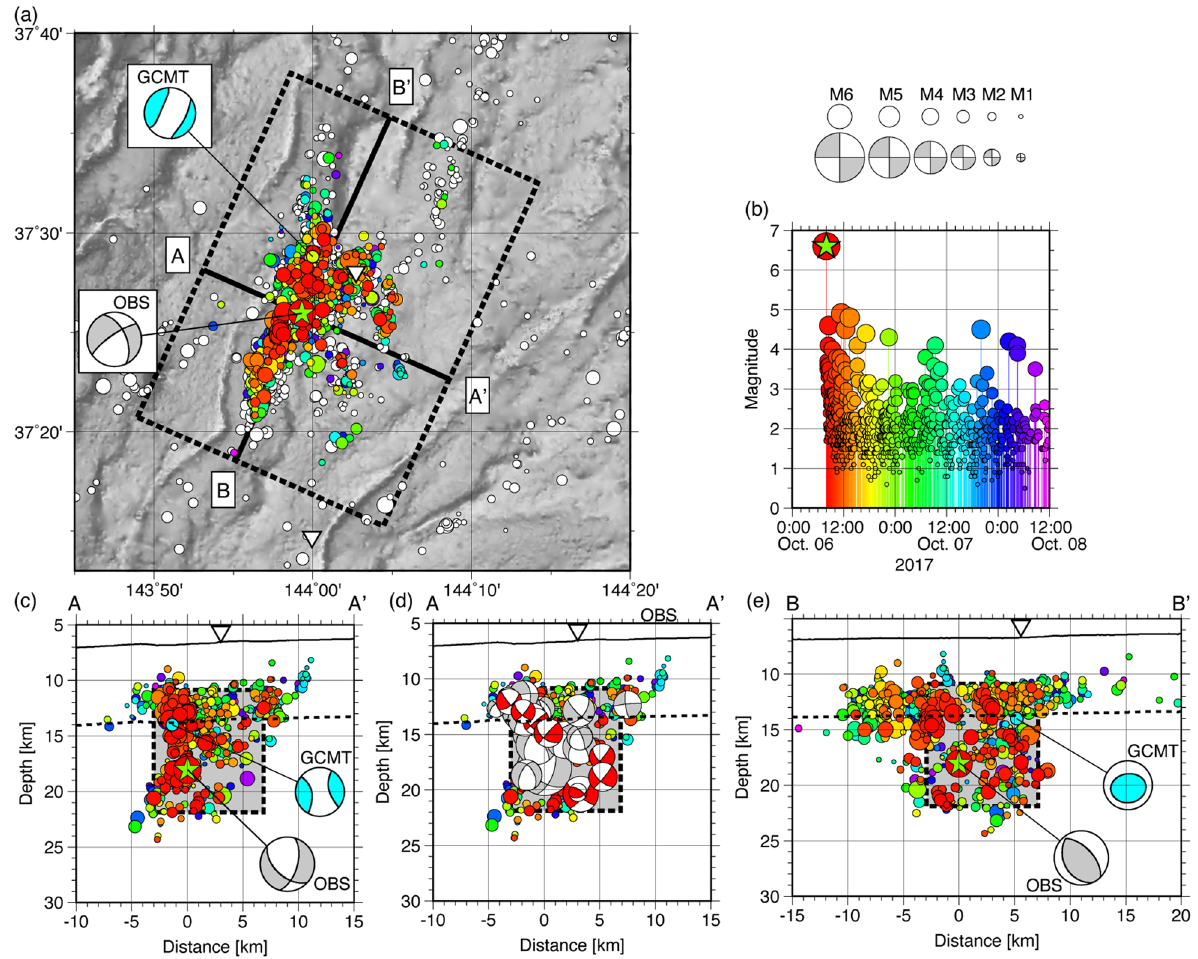
Fig. 5 Mainshock and aftershock activity of the October 06, 2017 earthquake. a Map showing the epicenter distribution of the October 06, 2017 earthquake and its aftershocks. The mainshock and aftershocks within the dashed rectangle are circles color-coded with time after the mainshock, as indicated in panel ( b ). The mainshock is marked with a green star. The focal mechanism of the mainshock from the GCMT catalog and OBS first-motion polarities are indicated. b Magnitude-time diagram of the earthquakes within the dashed rectangle on panel ( a ). c , d Cross sections of the hypocenters along the profile A–A’ on panel ( a ). Focal mechanisms from the OBS first-motion polarities are also indicated on panel ( d ). The focal mechanisms are color-coded by the faulting types according to the triangle diagram of Frohlich (1992), as shown in Fig. 2. The gray rectangle indicates the area of the earthquakes that occurred within 1 h from the mainshock. e Cross sections of the hypocenters along the profile B–B’